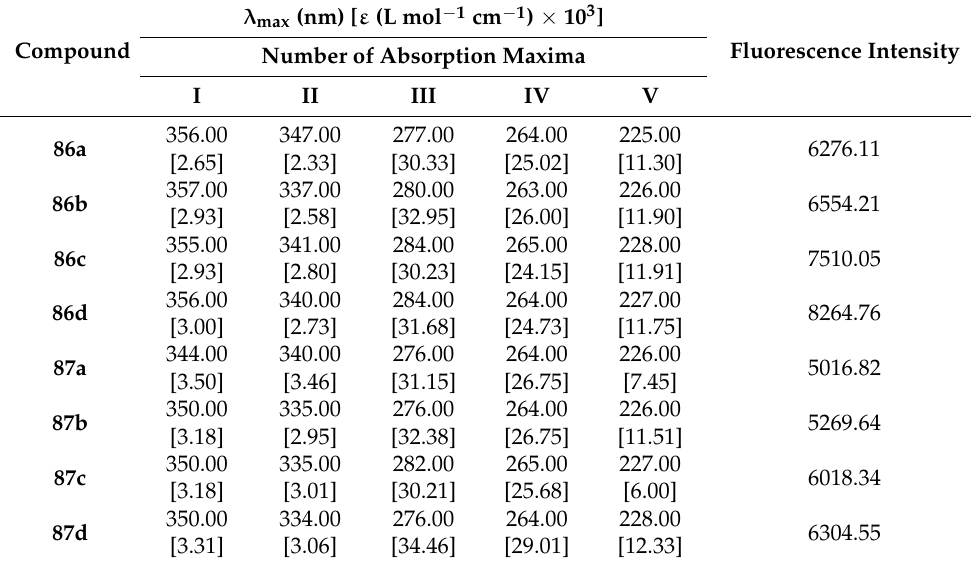
in acetonitrile solution (5 × 10 − 5